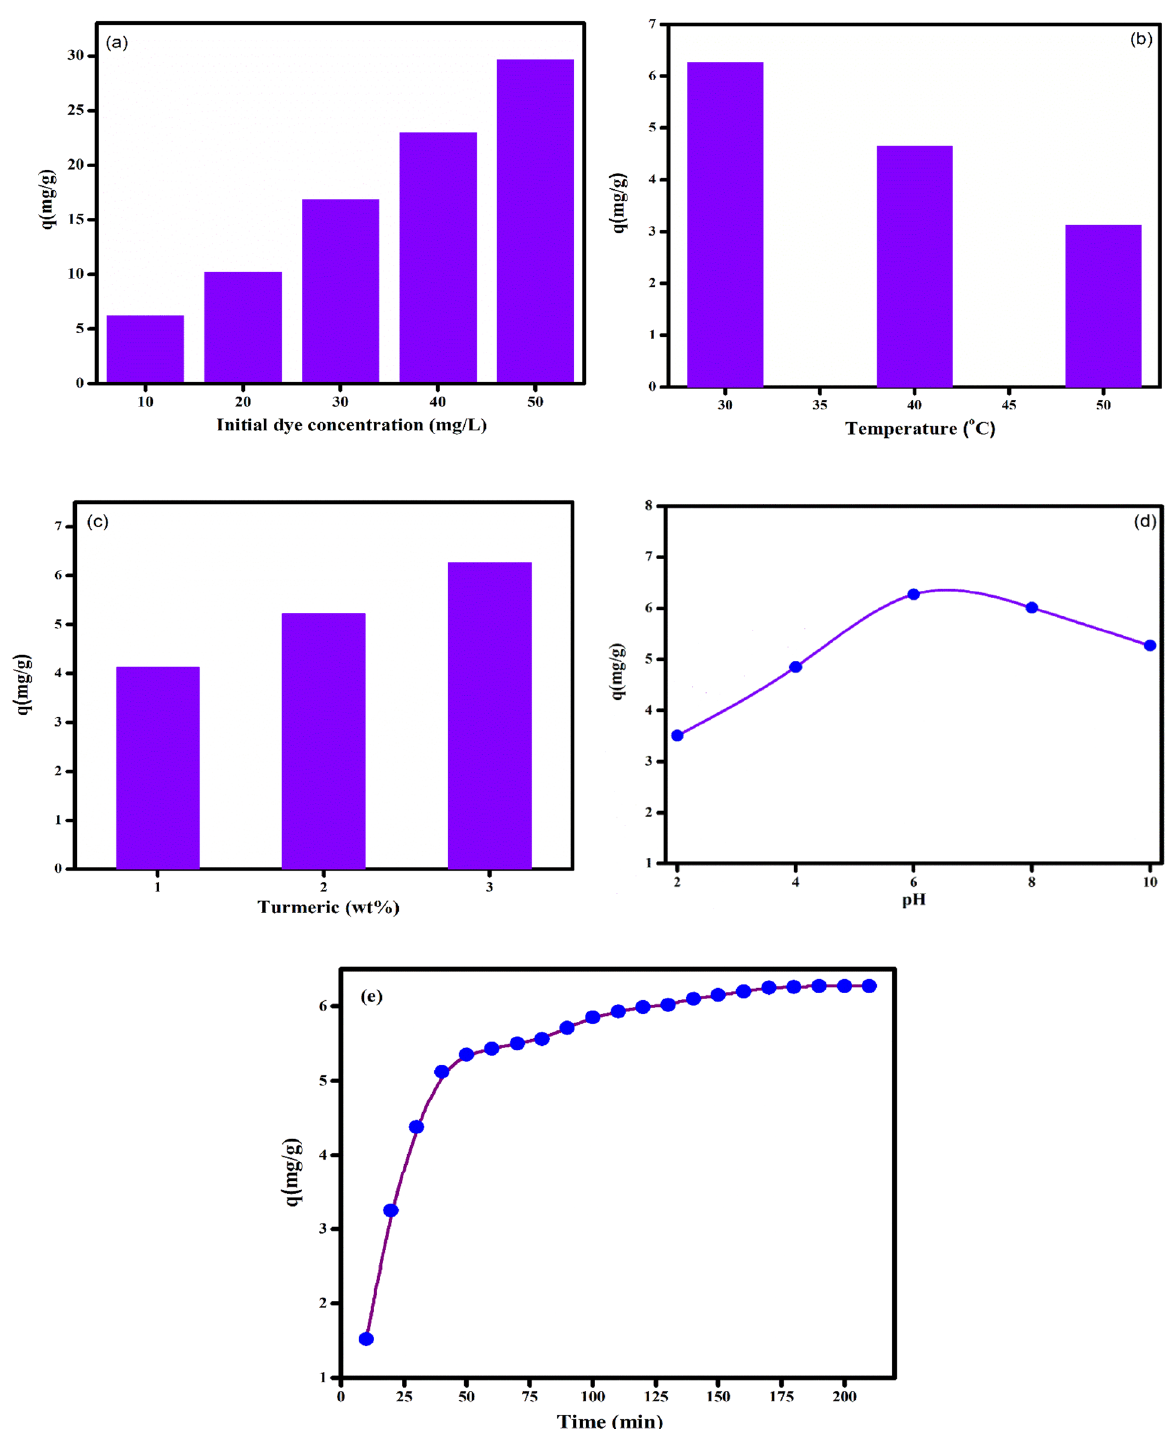
Figure 13. Effect of different parameters such as ( a ) initial dye concentration; ( b ) temperature; ( c ) turmeric dosage; ( d ) pH and ( e ) contact time on the MB removal dye on PVA/CMC/TUR films (Experimental condition: adsorbent dosage = 3 wt%, initial dye concentration = 10 mg/L, contact time = 170 min, pH = 6 and temperature = 30